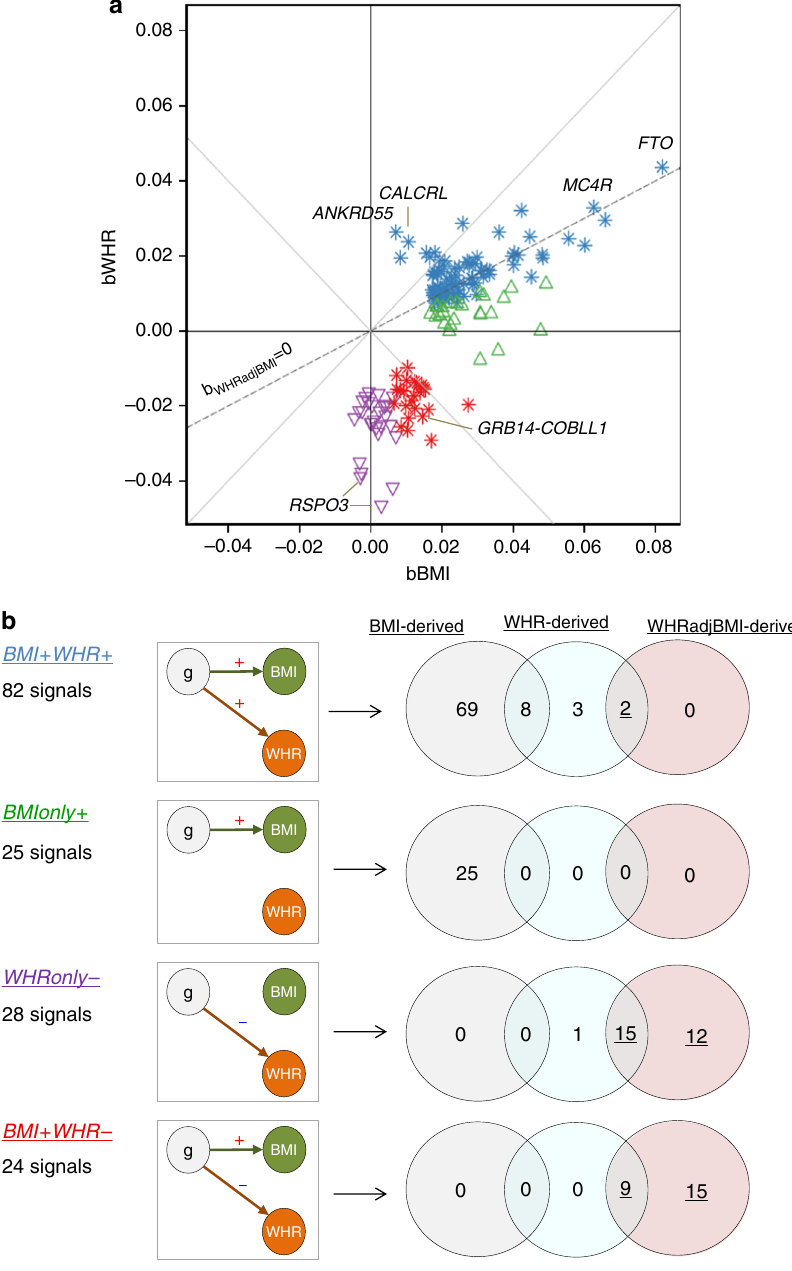
Fig. 2 Classi fi cation of 159 signals and overlap by scan. The fi gure visualizes the classi fi cation of the 159 independent signals according to the position on the b WHR - b BMI -plane and their overlap by scan. a The Scatter plot shows the 159 variants on the b WHR - b BMI -plane, where b WHR and b BMI are the variant ’ s effect on WHR and BMI, respectively. Coloring indicates the four classes: BMI + WHR + (blue, nominal signi fi cant effects on BMI and WHR with consistent directions), BMIonly + (green, nominal signi fi cant effects on BMI only), WHRonly − (purple, nominal signi fi cant effects on WHR only) and BMI + WHR − (red, nominal signi fi cant effects on BMI and WHR with opposite directions). Symbols indicate a nominal signi fi cance purely for BMI ( P BMI < 0.05, P WHR ≥ 0.05, upward triangle), purely for WHR ( P BMI ≥ 0.05, P WHR < 0.05, downward triangle), or for both ( P BMI < 0.05, P WHR < 0.05, stars). The dashed line indicates a null effect for WHRadjBMI ( b WHRadjBMI = 0, estimated as b WHR = r* b BMI , with the correlation between BMI and WHR estimated from the population-based CoLaus study, r = 0.50). b The diagram shows the number of identi fi ed signals per class, illustrates the four classes in directed acyclic graphs and shows Venn diagrams per class to distinguish whether the signals were derived with genome-wide-signi fi cance by the BMI − , the WHR − or the WHRadjBMI-scan, or by multiple scans. The underlined numbers re fl ect the 53 genome-wide signi fi cant signals identi fi ed by the